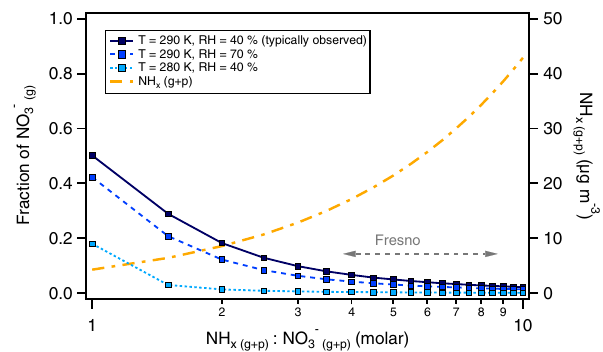
Figure 3. The gaseous fraction of total nitrate versus the molar ratio of total ammonia to total nitrate (ppb) under different environmental conditions (blue lines). The total ammonia is the sum of NH 3 ( g ) measured on the P3-B close to ground ( < 20ma.g.l.) and NH + 4 ( p ) at ground level measured by PILS at approximately same time. The total nitrate is the NO − measured by TD-LIF close to ground 3 (g + p) ( < 20ma.g.l.). The gray dashed arrow indicates the observed range of molar ratio values during the campaign period. The total (gas + particle) ammonia is shown for reference (orange